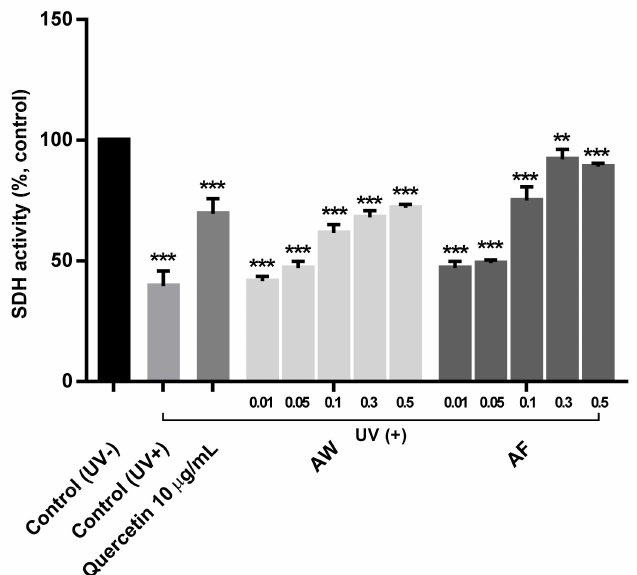
Figure 6. Comparison of succinate dehydrogenase activities, a component of mitochondrial complex II, in UV b -irradiated human skin fibroblasts treated with 10 µ g/mL quercetin or various concentra- tions of the two aloe extract samples. AW: Hot water extraction of Aloe vera leaf skin at 100 ◦ C for 24 h. AF: L. plantarum fermentation of Aloe vera leaf skin at 37 ◦ C for 3 days and extraction with an ultrasonicator at 40 kHz for 1 h at room temperature. The mean values ± SD for separate triplicate experiments are shown, and error bars represent the SD. The significance of the difference was set to ** p < 0.01 and *** p < 0.001 compared with the control (UV − )